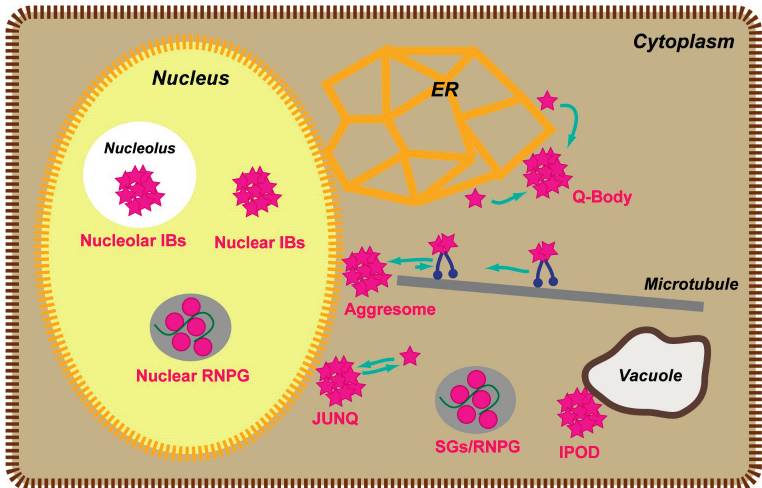
Figure 2. Illustration of typical inclusion bodies (IBs) in eukaryotic cells. Q-body is ER-associated puncta that concentrate different misfolded and stress-denatured proteins en route to degradation. RNPG—ribonucleoprotein